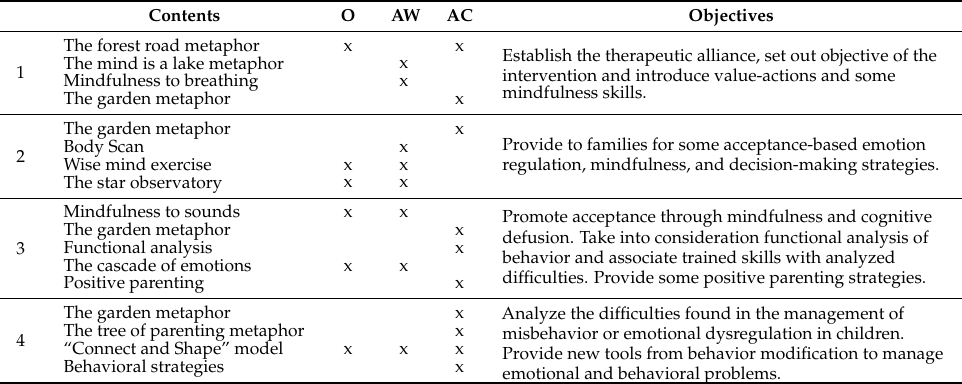
Table 1. Exercises and objectives of the clinical